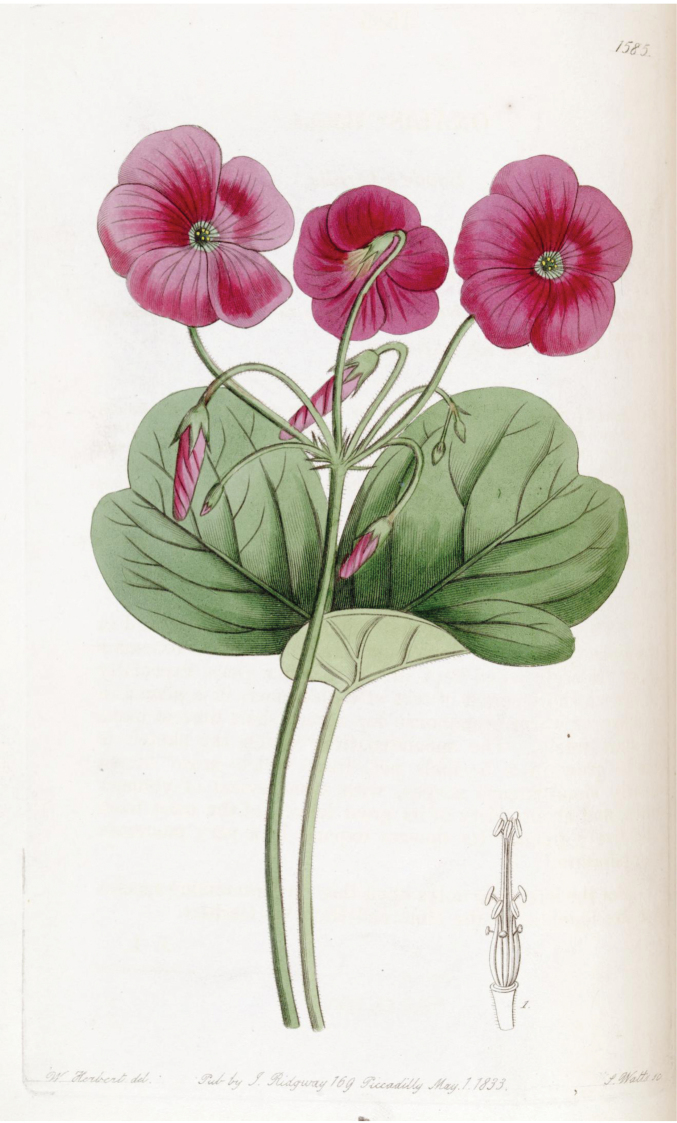
The illustration of Oxalisbowiei from Edward’s Botanical Register (Lindley 1833). https://biodiversitylibrary.org/page/239525